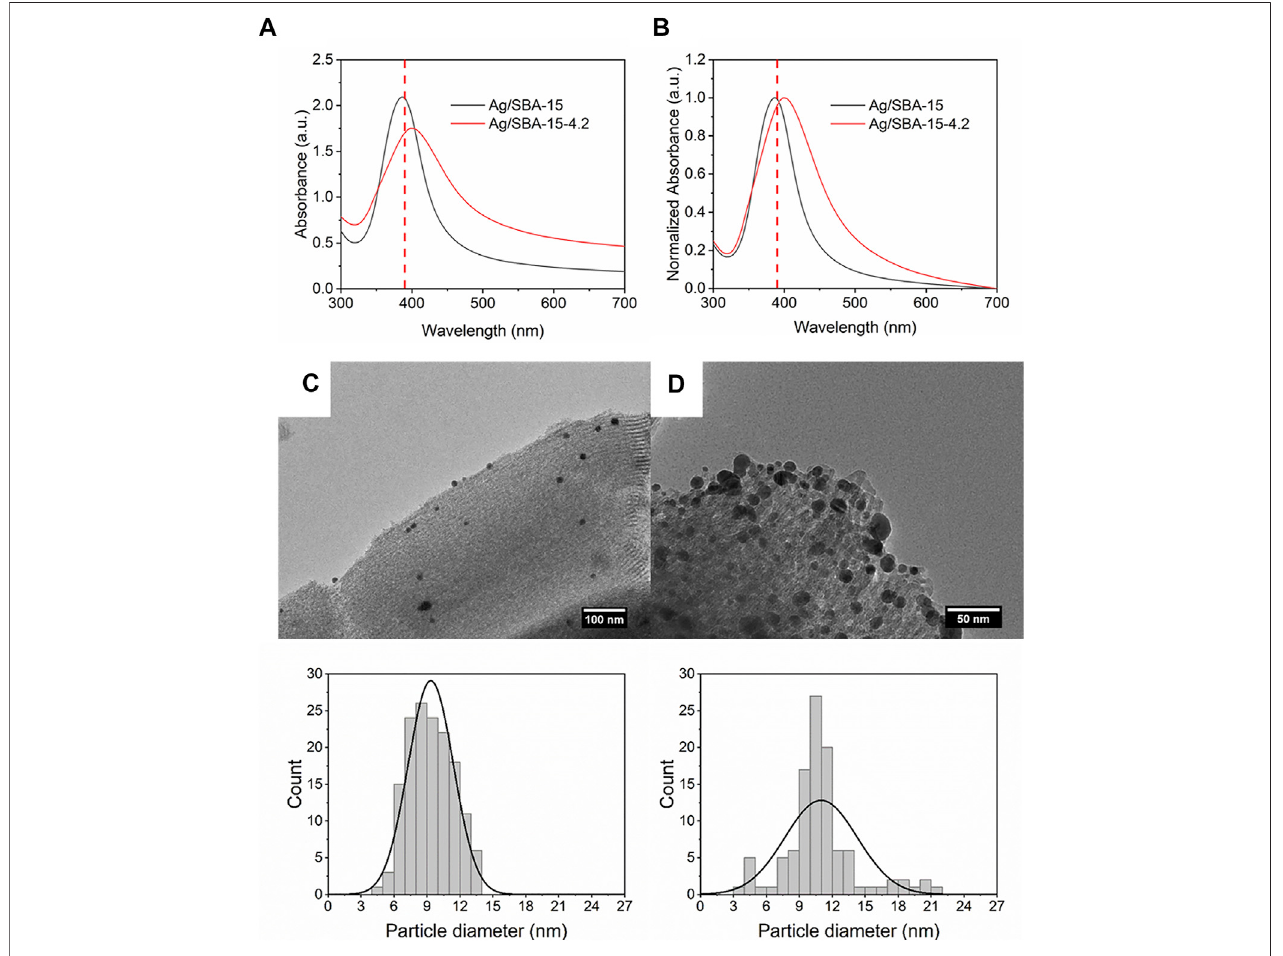
FIGURE9|(A) UV-Visabsorbancespectraand (B) normalizedabsorbancespectraforAg/SBA-15andAg/SBA-15-4.2.TEMimagesandsizedistributionofsilver nanoparticles dispersed on SBA-15 and SBA-15-4.2 (C) Ag/SBA-15 (9.35 ± 2.06 nm), and (D) Ag/SBA-15-4.2 (10.98 ± 3.30 nm).